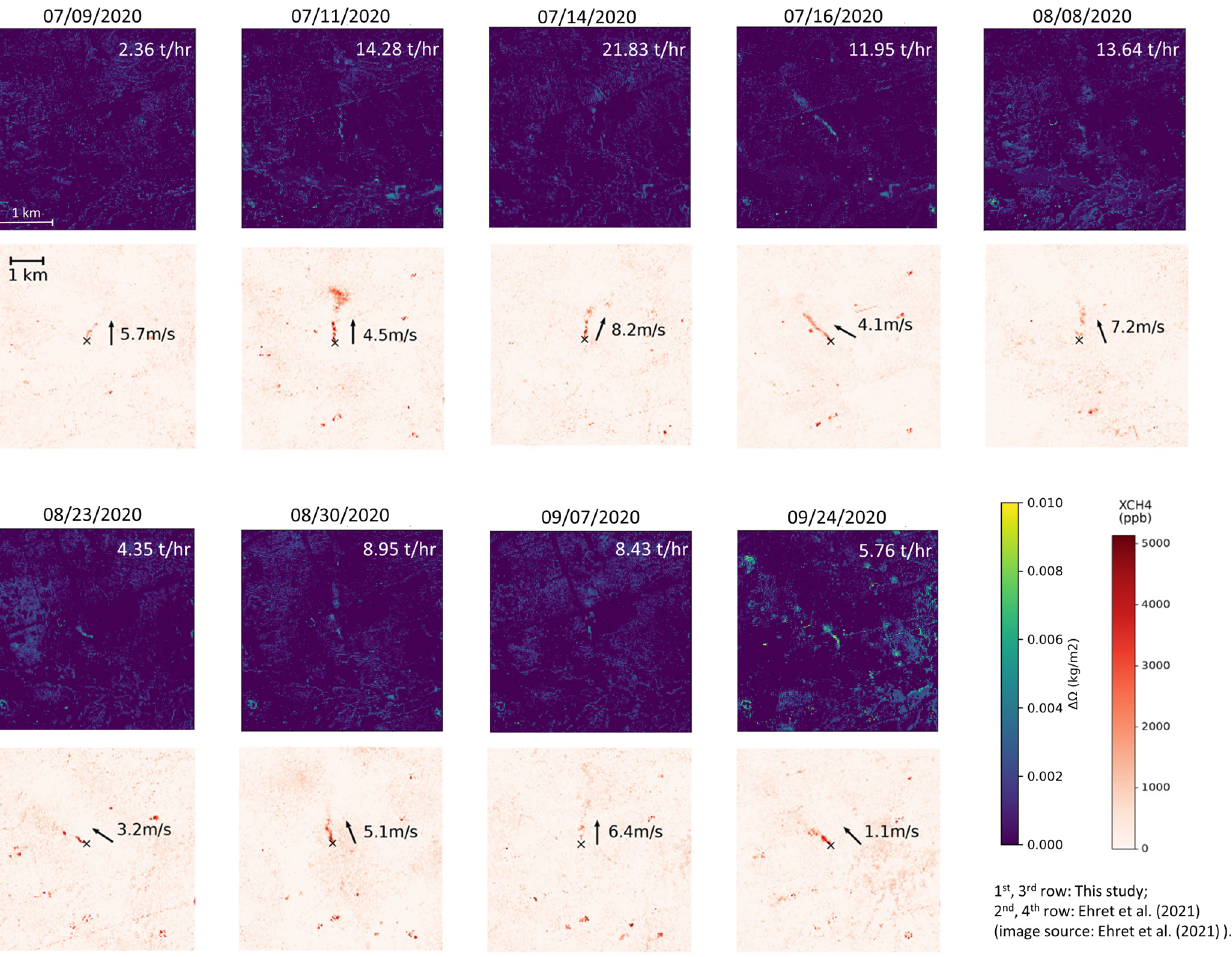
Figure 8. Examination of true positives. The application site is in the Permian basin during the summer of 2020 studied in Ehret et al. (2022) (31.7335 ◦ N, 102.0421 ◦ W). The first and third rows show plume observation of this study, and the second and fourth rows show plume observation from Ehret et al. (2022) (image source: Ehret et al., 2022). All nine plumes represented in Ehret et al. (2022) were detected with similar shapes in this study. The emission rate estimate difference is within ± 55% of Ehret et al.